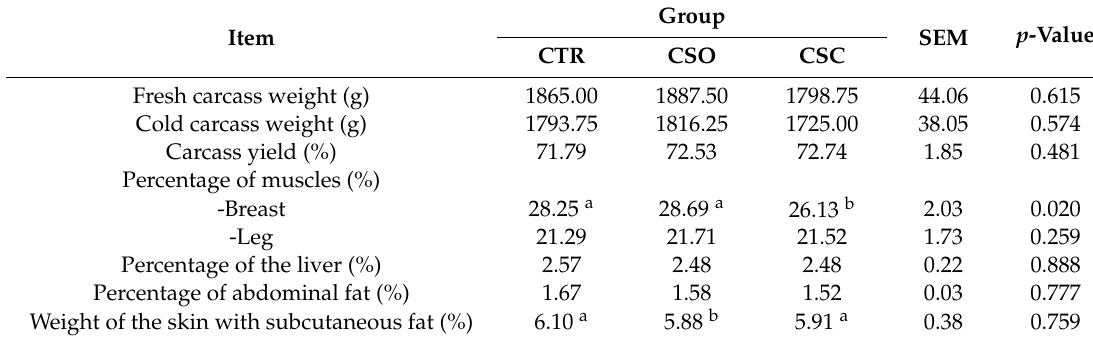
Table 5. Slaughter analysis of the carcasses of broiler chickens.